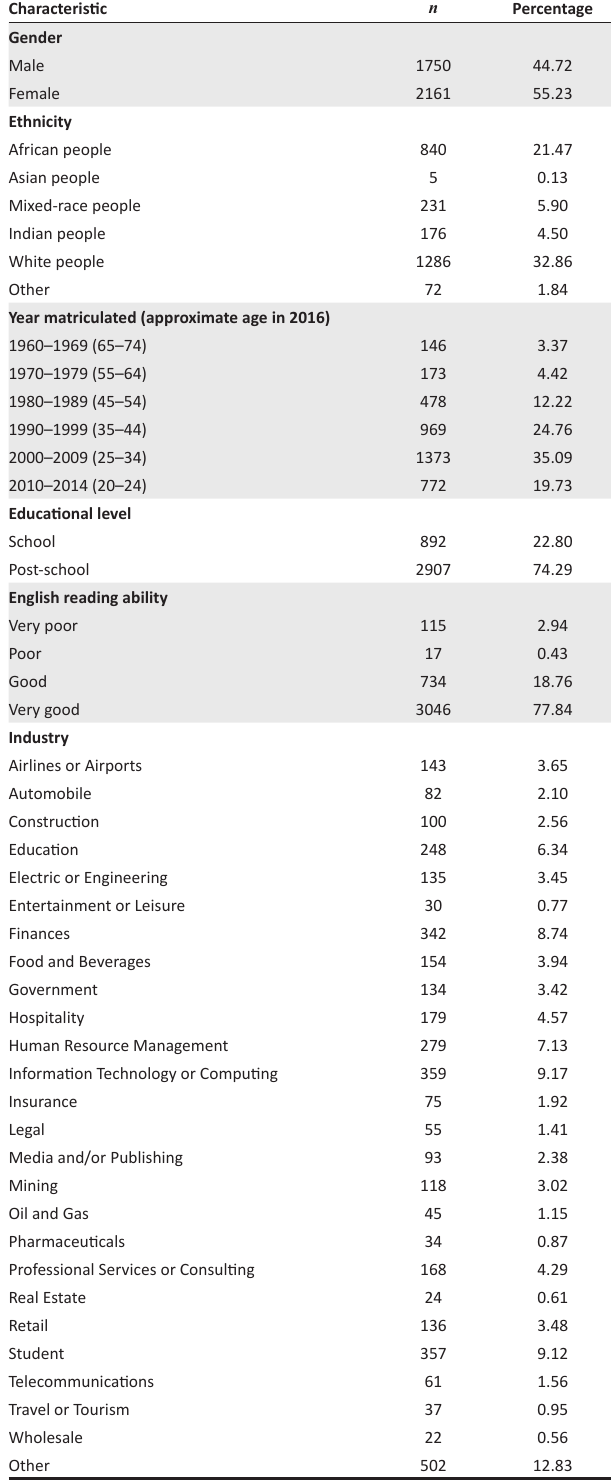
TABLE 1: Characteristics of the participants ( N =